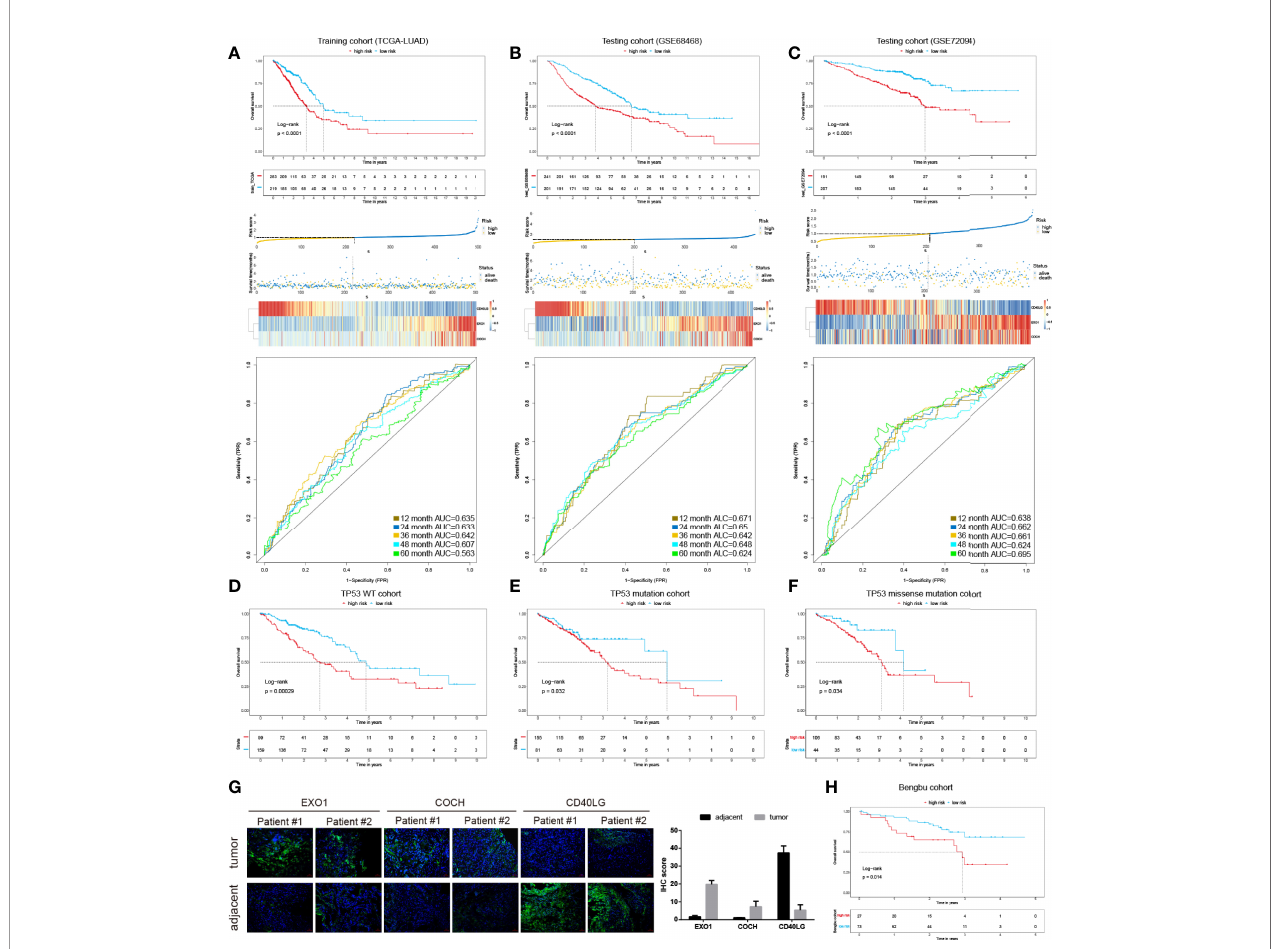
FIGURE 2 | The development and validation of the immune prognostic model (IPM). KM survival risk table, and ROC cures of the IPM in TCGA LUAD (A) , GSE68468 (B) , and GSE72094 (C) cohorts. KM survival curves of overall survival according to TP53 wild type groups (D) , TP53 mutation (E) , and TP53 missense mutation subgroups (F) . (G) IHC of EXO1, COCH, and CD40LG in tumor and adjacent samples. (H) KM survival curves in the Benbu